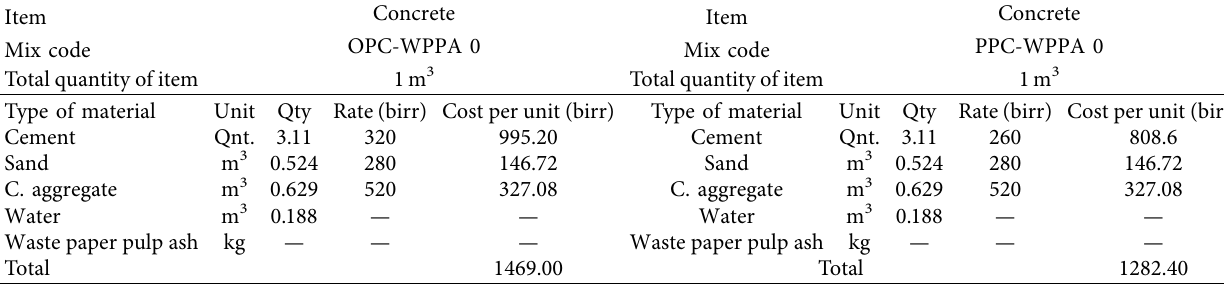
Table 16: OPC-WPPA0 and PPC-WPPA0.